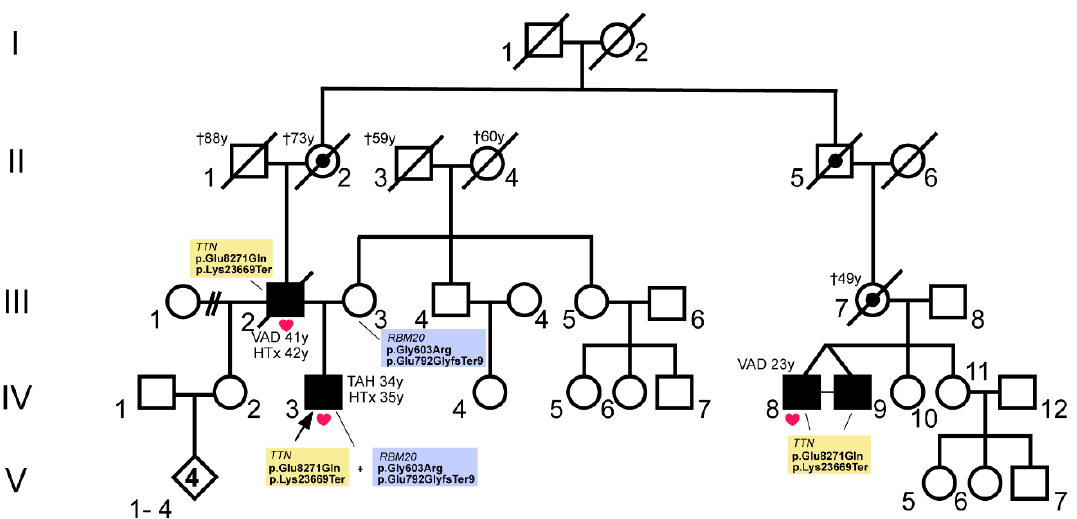
Figure 1. Pedigree of a cardiomyopathy family with (likely) pathogenic RBM20 and TTN mutations. Circles represent females, squares males, slash denotes deceased. The index patient (IV.3) is marked with an arrow. Available myocardial tissue of patients with end-stage heart failure, who received heart transplantation (HTx) or mechanical circulatory support (left ventricular assist device (VAD) or total artificial heart (TAH)) were indicated with red heart symbols. Affected members with dilated cardiomyopathy (DCM) are shown in black and obligate mutation carriers of the TTN mutations are marked with a dot. The age of the patients in years (y) at the time of HTx, VAD- or TAH implantation or at the time of death (†) is specified. The respective genotypes of the analyzed patients are shown in the figure.